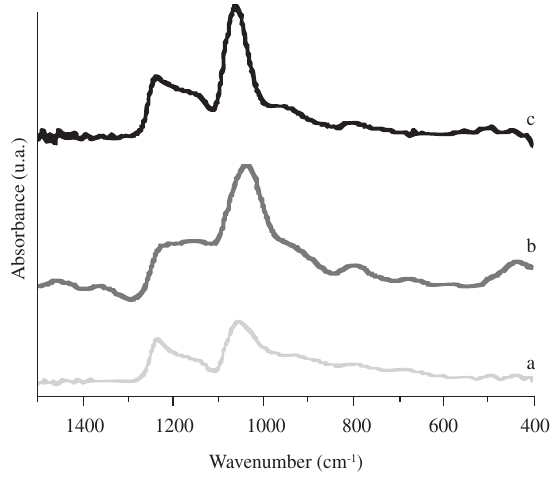
Figure 4. FTIR spectra of a) unary film; b) binary film; c) ternary film at 400 °C for 15 minutes at 75° of incidence.